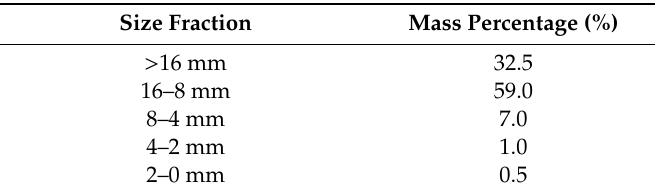
Table 2. CSP mass percentage.